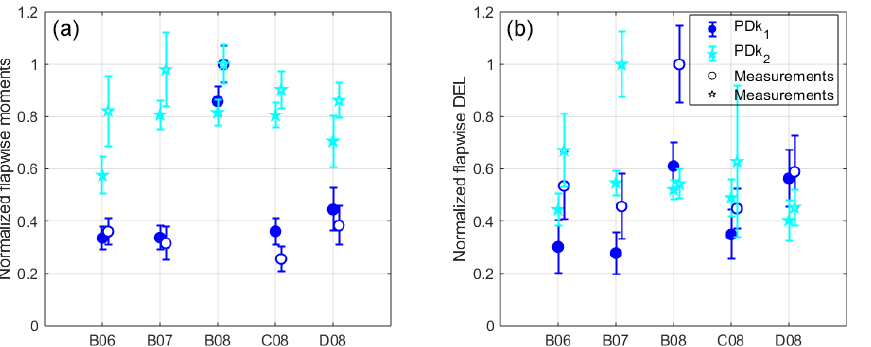
Figure 17. Comparison of LES time-averaged blade root flap-wise moments (a) and DEL (b) against field measurements. Error bars represent 95% confidence intervals on the mean. Results are normalized by maximum SCADA data for each case.